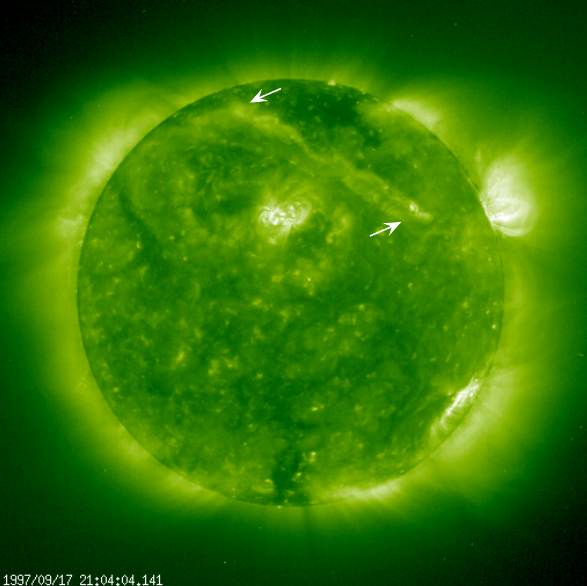
Fig. 3. White arrows show more than 60 ◦ extension of a new arcade formation after filament eruption (Event 13) in UVI 195 ˚A whole disk image of the low sun